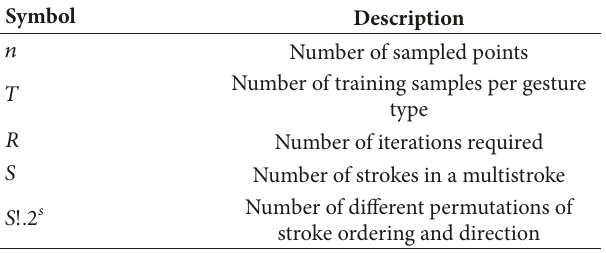
Table 2: Description of $-Family Recognizer